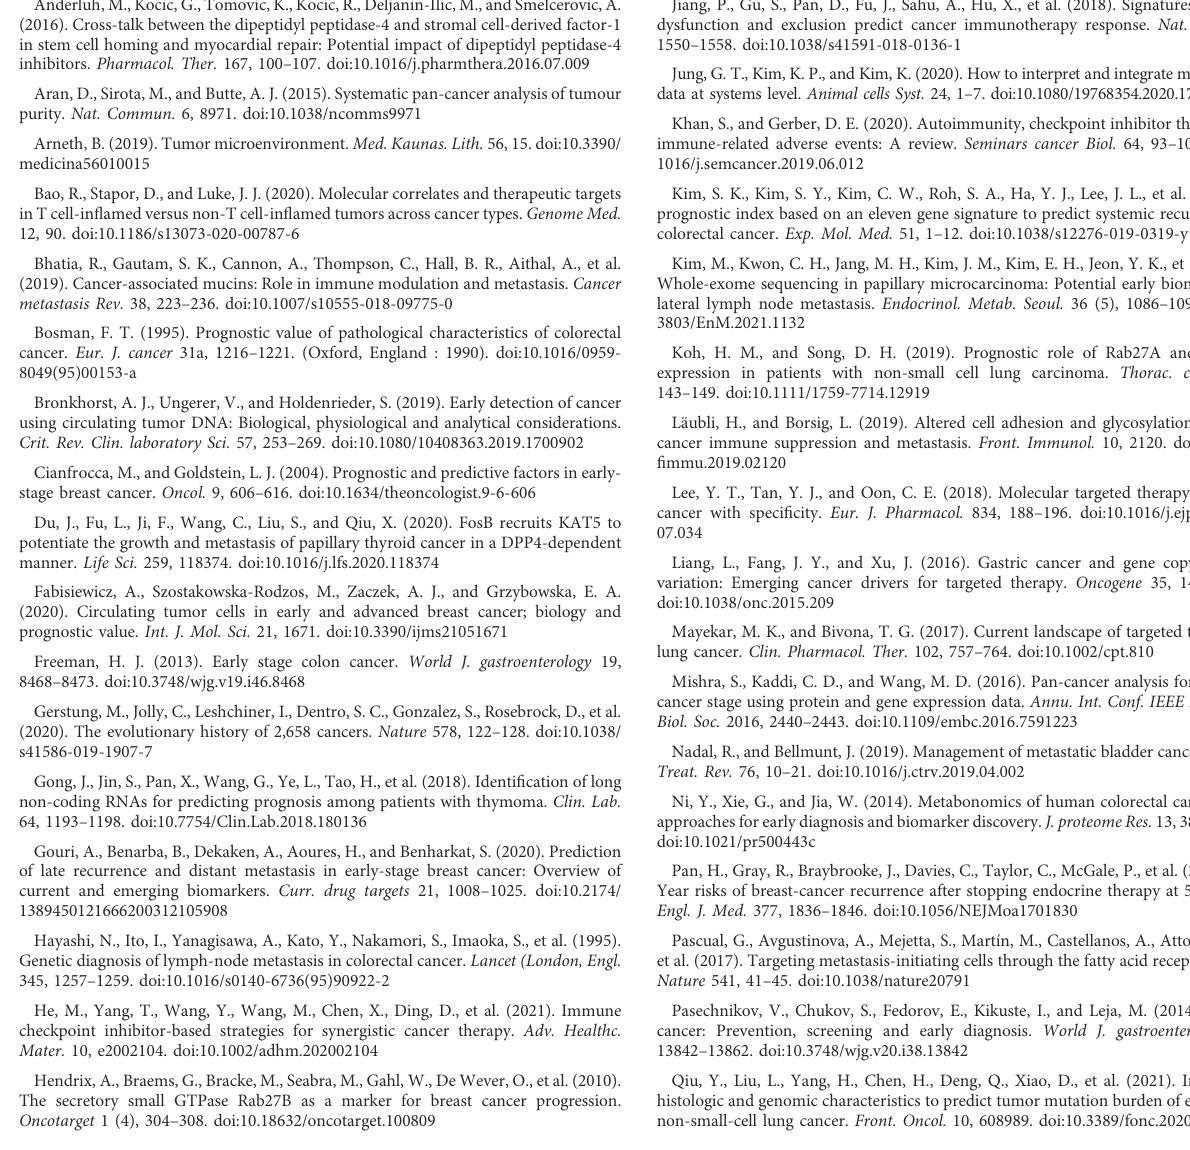
SUPPLEMENTARY FIGURE S3 (A) : Comparison of recurrent tumors with primary tumors, the boxplot of the expression of stage I speci fi c differentially expressed genes. (B) : Comparison of metastatic tumors with primary tumors, the boxplot of the expression of stage I speci fi c differentially expressed genes. The ordinate was the normalized gene expression value. SUPPLEMENTARY FIGURE S4 The proportion of samples with copy number variation in primary, recurrent and metastatic patients at stage II, III, IV+V. The ordinate was the copy